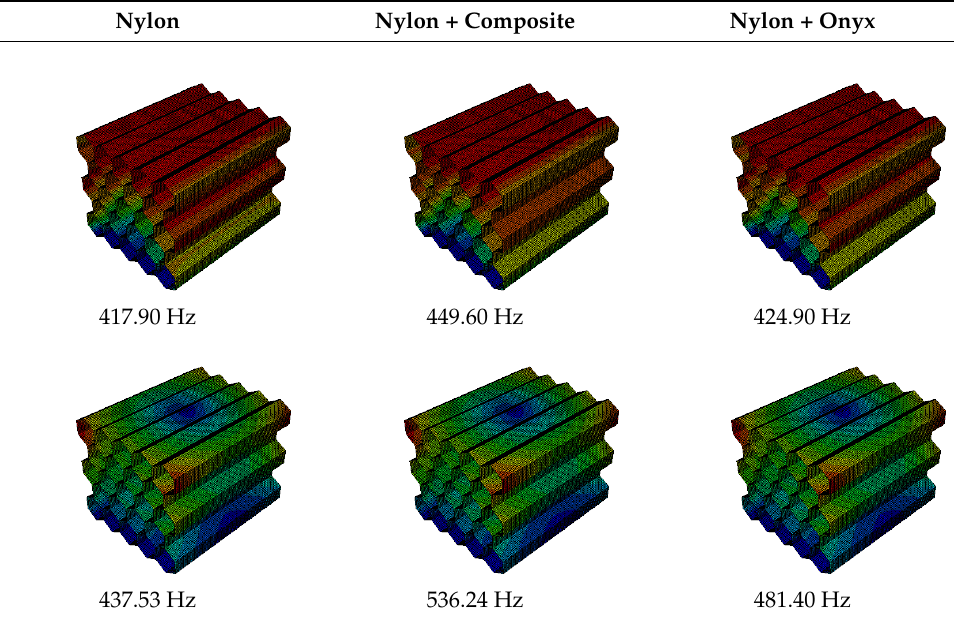
Table 6. Cont. Nylon Nylon + Composite Nylon + Onyx